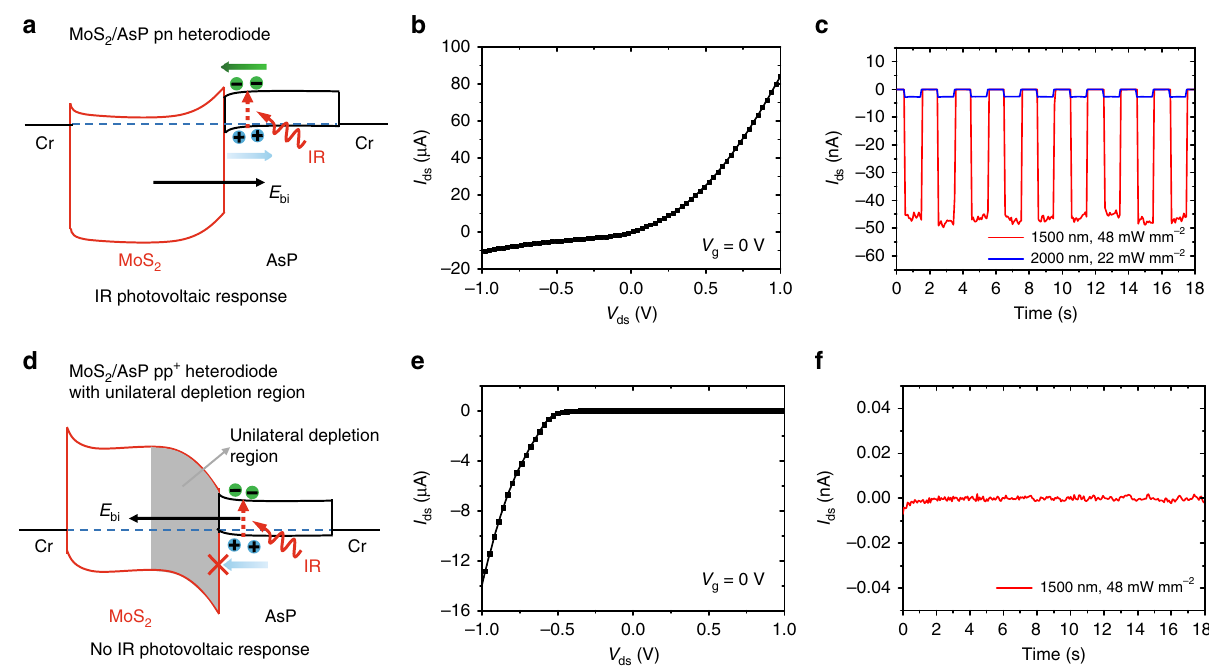
Fig. 3 Distinction of the different band structures of the MoS 2 /AsP pn and pp + heterodiodes. Energy band diagrams of the a MoS 2 /AsP pn heterodiode and d MoS 2 /AsP pp + heterodiode under IR laser illumination at zero bias. I ds – V ds curves of the b MoS 2 /AsP pn heterodiode and e MoS 2 /AsP pp + heterodiode. c IR (1500 and 2000nm) photovoltaic response of the MoS 2 /AsP pn heterodiode. f IR (1500nm) photovoltaic response of the MoS 2 /AsP pp + heterodiode with unilateral depletion